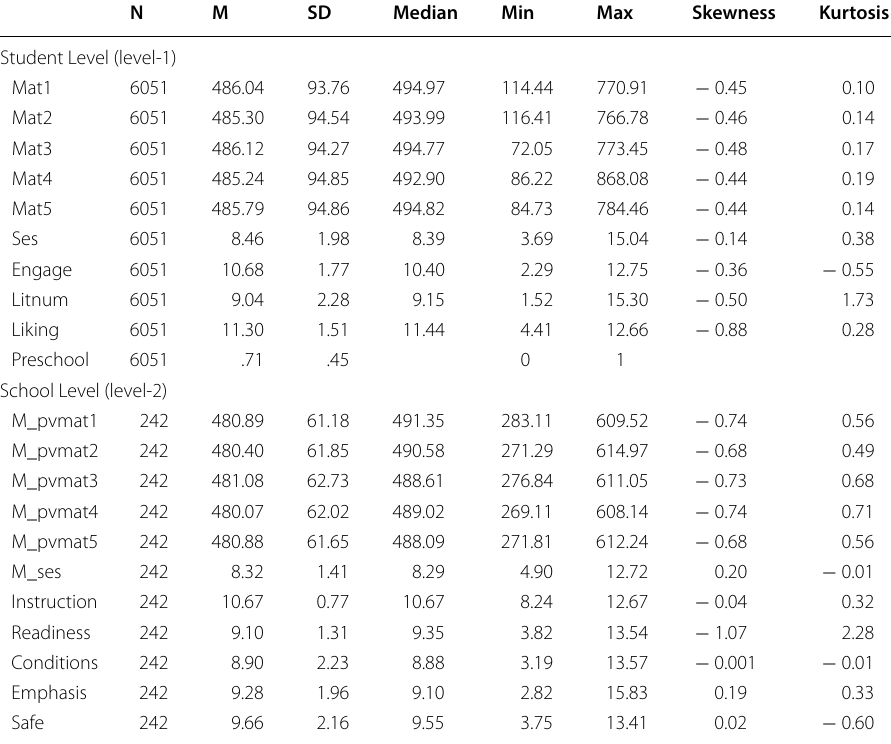
Table 3 Descriptive statistics of the sample at the student and school levels N M SD Median Min